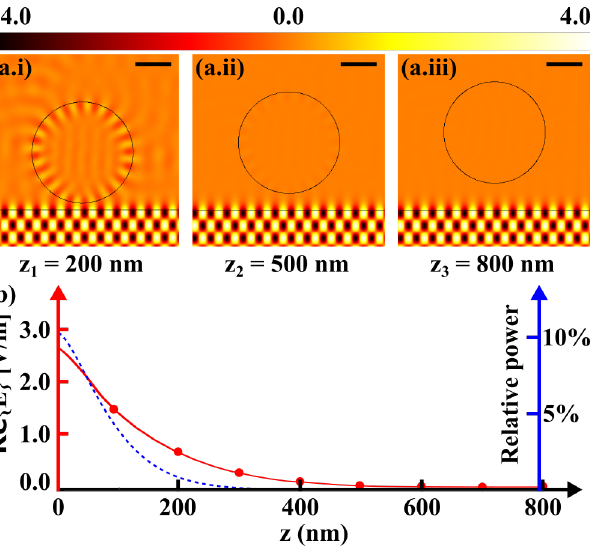
Figure 2. Collection efficiency of an evanescent wave by a glass microsphere at an axial gap with the interface. ( a.i ), ( a.ii ) and ( a.iii ) Real parts of the electric field distributions when the microsphere is positioned at a distance of 200 nm, 500 nm and 800 nm from the interface, respectively. Black-scale bars represent 1 µm. ( b ) Real-part peak amplitude of the WGM electric field along the microsphere rim and relative power transmitted by the microsphere in the far field as a function of the z distance. λ 0 = 600 nm, θ = 1 rad, ψ = 0 rad, n s = 1.5, D = 3